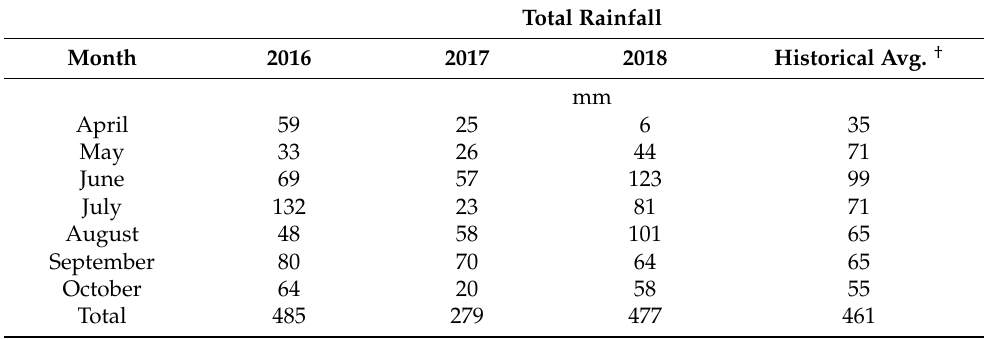
Table 3. Monthly total rainfall in 2016, 2017, and 2018 compared with the 30-year average at Fargo, ND,